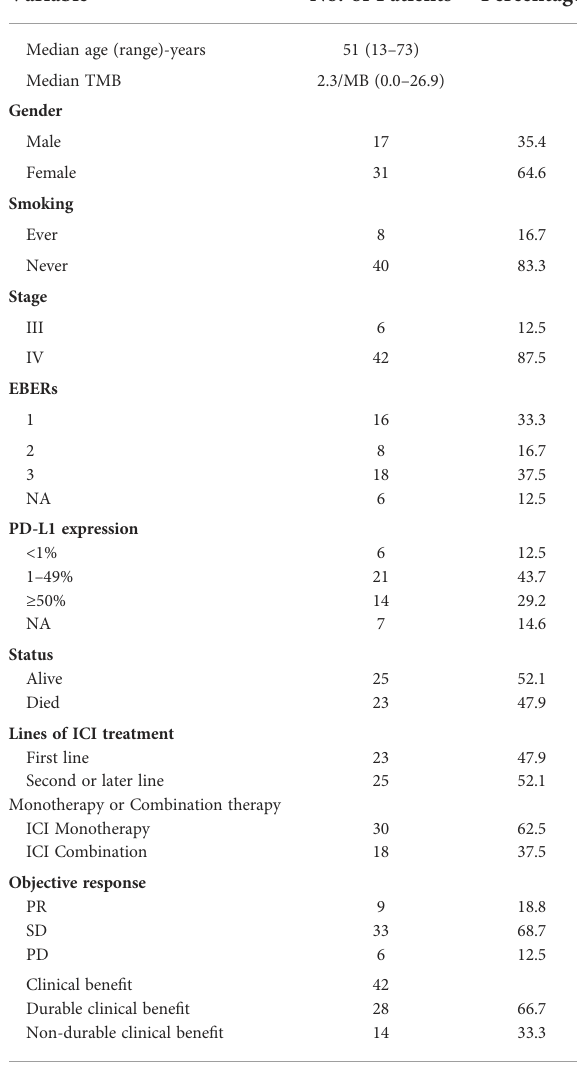
TABLE 1 Clinical characteristics of the 48 ICI-treated PLELC